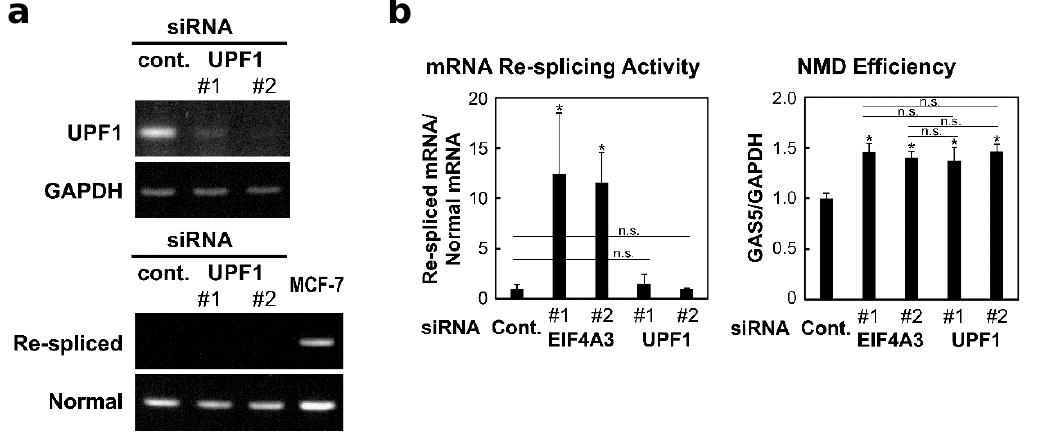
Figure 3. Activation of mRNA re-splicing by the knock-down of EJC core factors is not due to the repression of EJC-mediated NMD: ( a ) To knock-down the expression of endogenous NMD factor UPF1, MCF-10A cells were transfected with the indicated siRNAs. To observe the knocked-down mRNA and TSG101 re-splicing activity, the extracted total RNAs were analyzed by RT – PCR. MCF-7 cells (control) show the re-spliced mRNA that lacks in other lanes using MCF-10A cells. ( b ) HeLa cells were transfected with EIF4A3 or UPF1 siRNAs (or control siRNA). To evaluate the re-splicing activity with TSG101 mRNA and the NMD efficiency with GAS5 mRNA, the extracted total RNAs were analyzed by RT – qPCR using specific primer sets. The histograms represent the means ± standard deviations of three replicates (* p < 0.05, n.s. = not statistically significant p > 0.05).